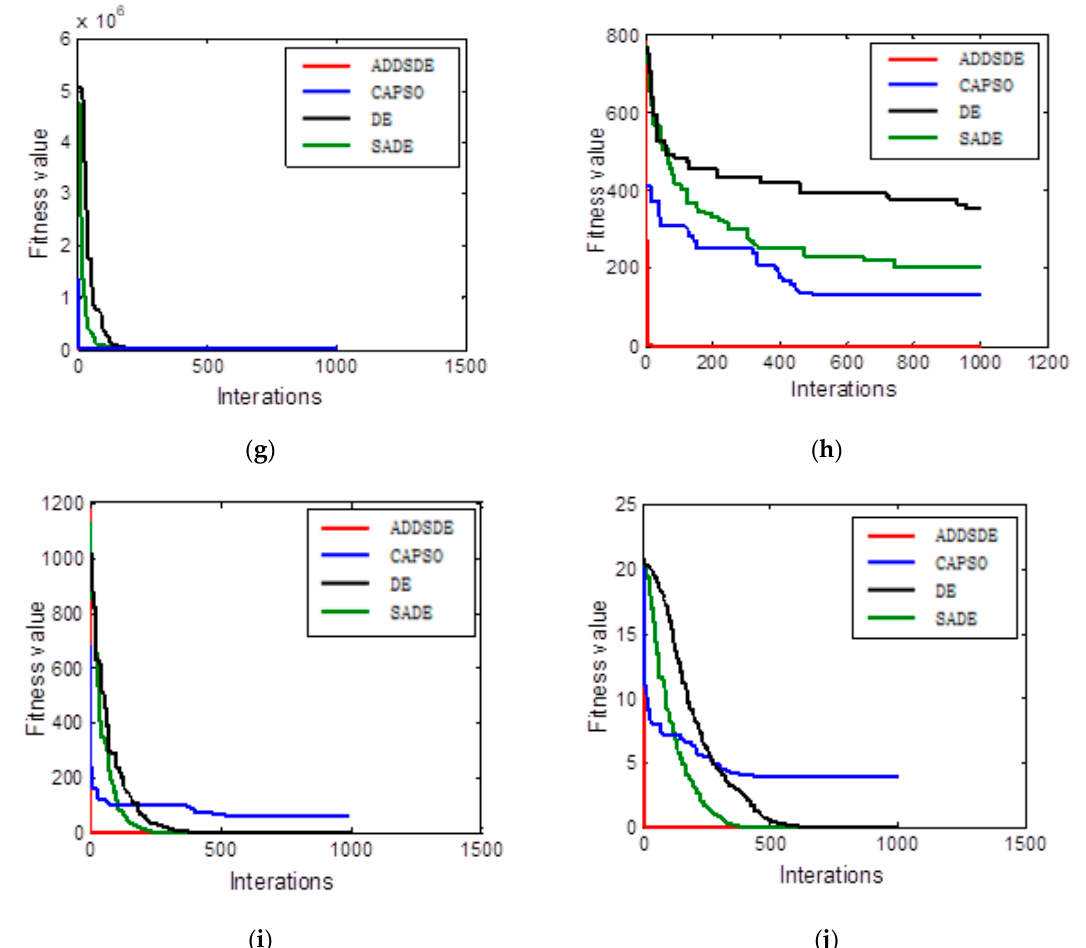
Figure 1. Convergence curve of each algorithm: ( a ) Function f1 = Sphere when D = 30; ( b ) Function f2 = Rosenbrock when D = 30; ( c ) Function f3 = Rastrigin when D = 30; ( d ) Function f4 = Griewank when D = 30; ( e ) Function f5 = Ackley when D = 30; ( f ) Function f1 = Sphere when D = 50; ( g ) Function f2 = Rosenbrock when D = 50; ( h ) Function f3 = Rastrigin when D = 50; ( i ) Function f4 = Griewank when D = 50; and ( j ) Function f5 = Ackley when D = 50.